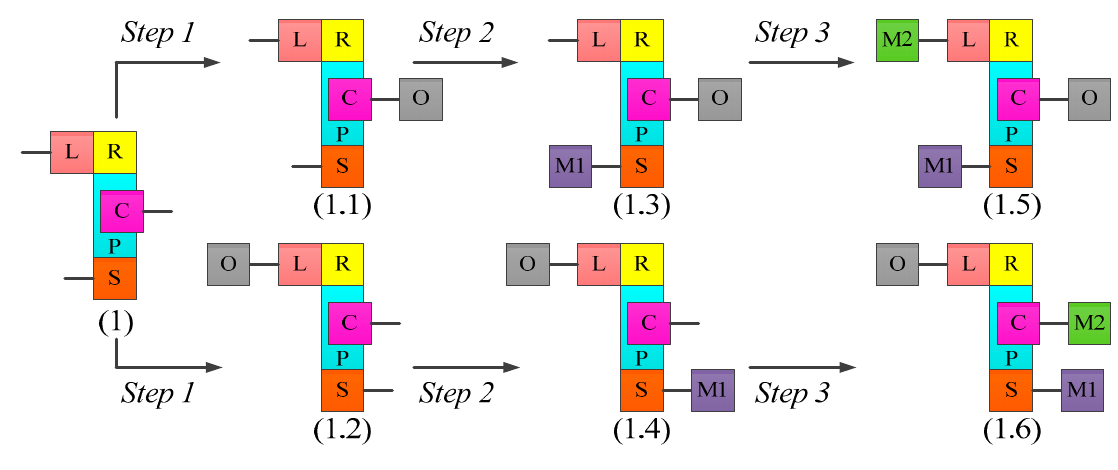
Figure 7. The power arrangement procedure.